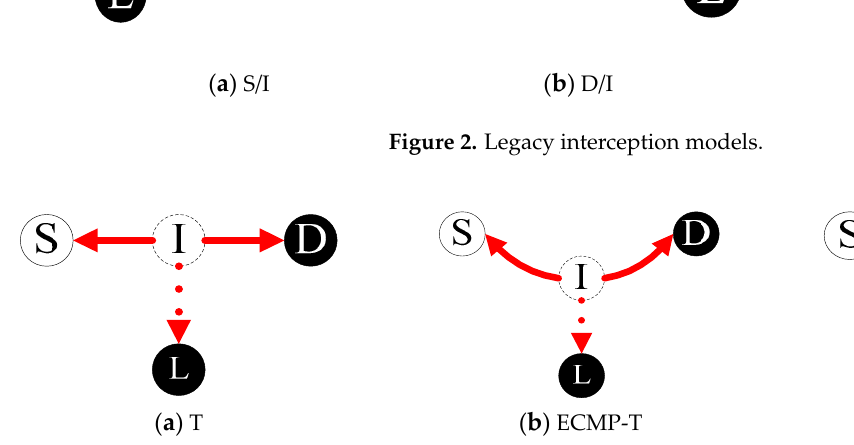
Figure 3. SDN interception models.